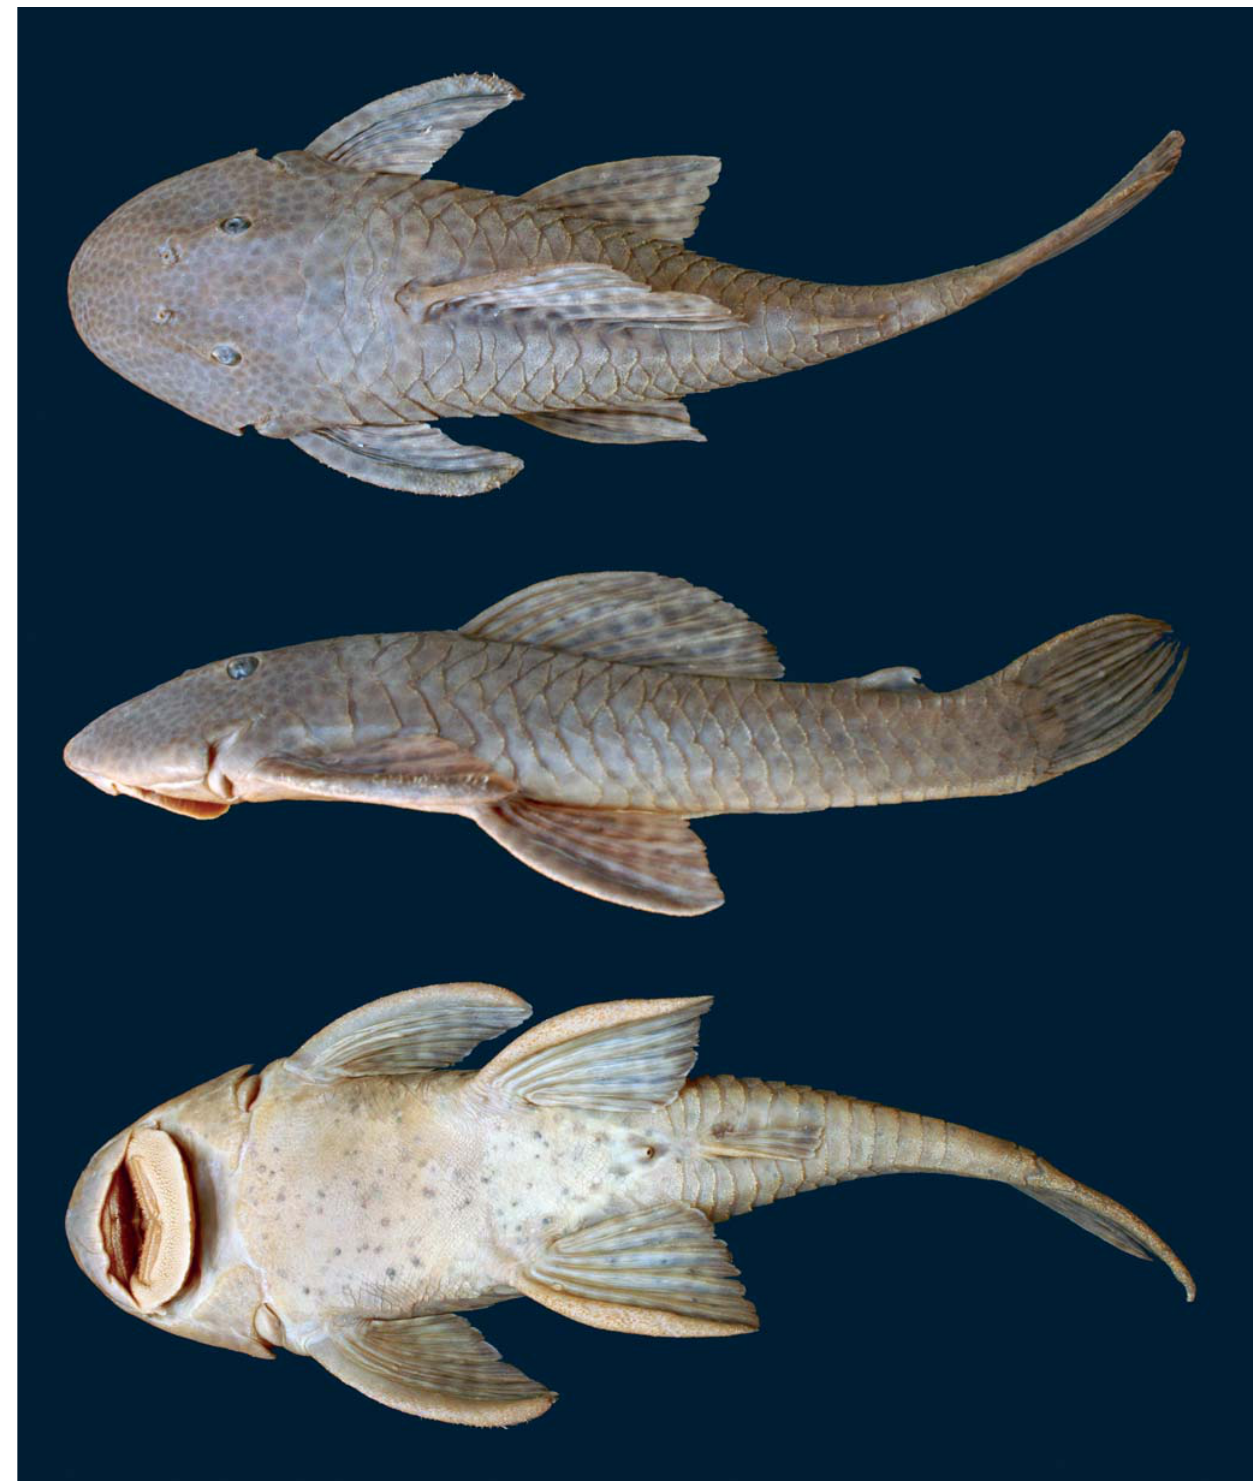
Fig. 5. Hypostomus heraldoi , holotype, Brazil, Goiás State, Município de Caldas Novas, rio Pirapitinga, MZUSP 98771, 217.9 mm SL. Dorsal, lateral, and ventral snout rounded in dorsal view. Median longitudinal bulge as- slightly convex in frontal view. A pair of weak ridges on dor- sociated with mesethmoid usually conspicuous from snout sal surface of head, each one beginning lateral to naris, pass- tip to transverse line between nares. Eye small (12.0 to 13.7% ing through upper margin of orbit and finishing on central of HL), dorsolaterally placed. Interorbital space straight or portion of pterotic-supracleithrum. Supraoccipital bone with-